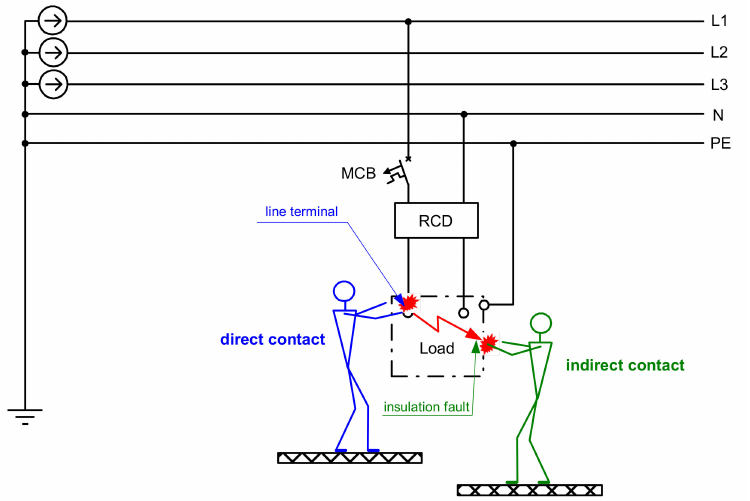
Figure 1. Electric shock due to direct contact with live parts or due to insulation fault (indirect contact); RCD, residual current device; MCB, overcurrent protective device (miniature